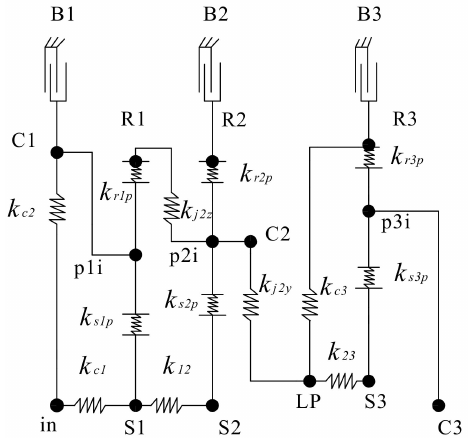
Figure 6. Dynamics model of three planetary gear set